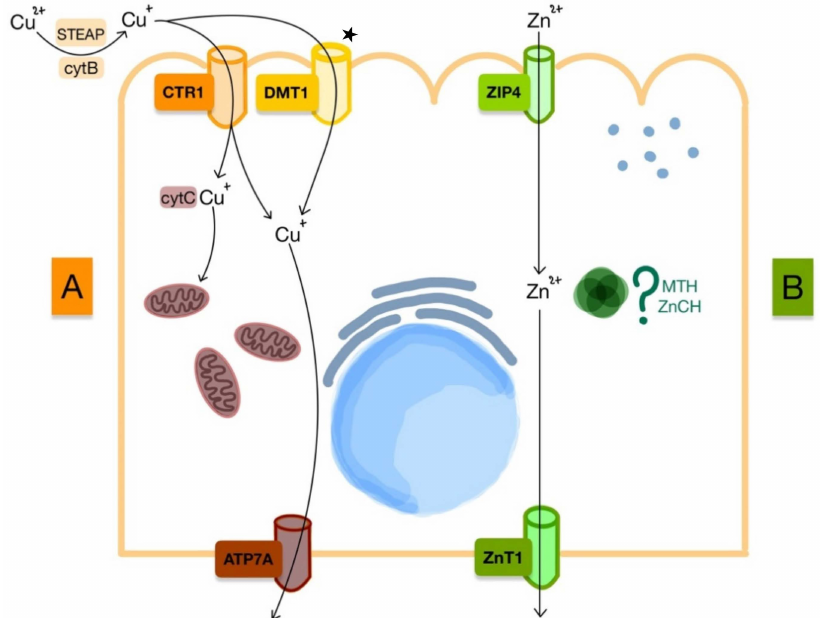
Figure 4. Absorption of ions by enterocyte. ( A ) Cu absorption during normal homeostasis and in iron deficiency; main pathway during iron deficiency marked with normal